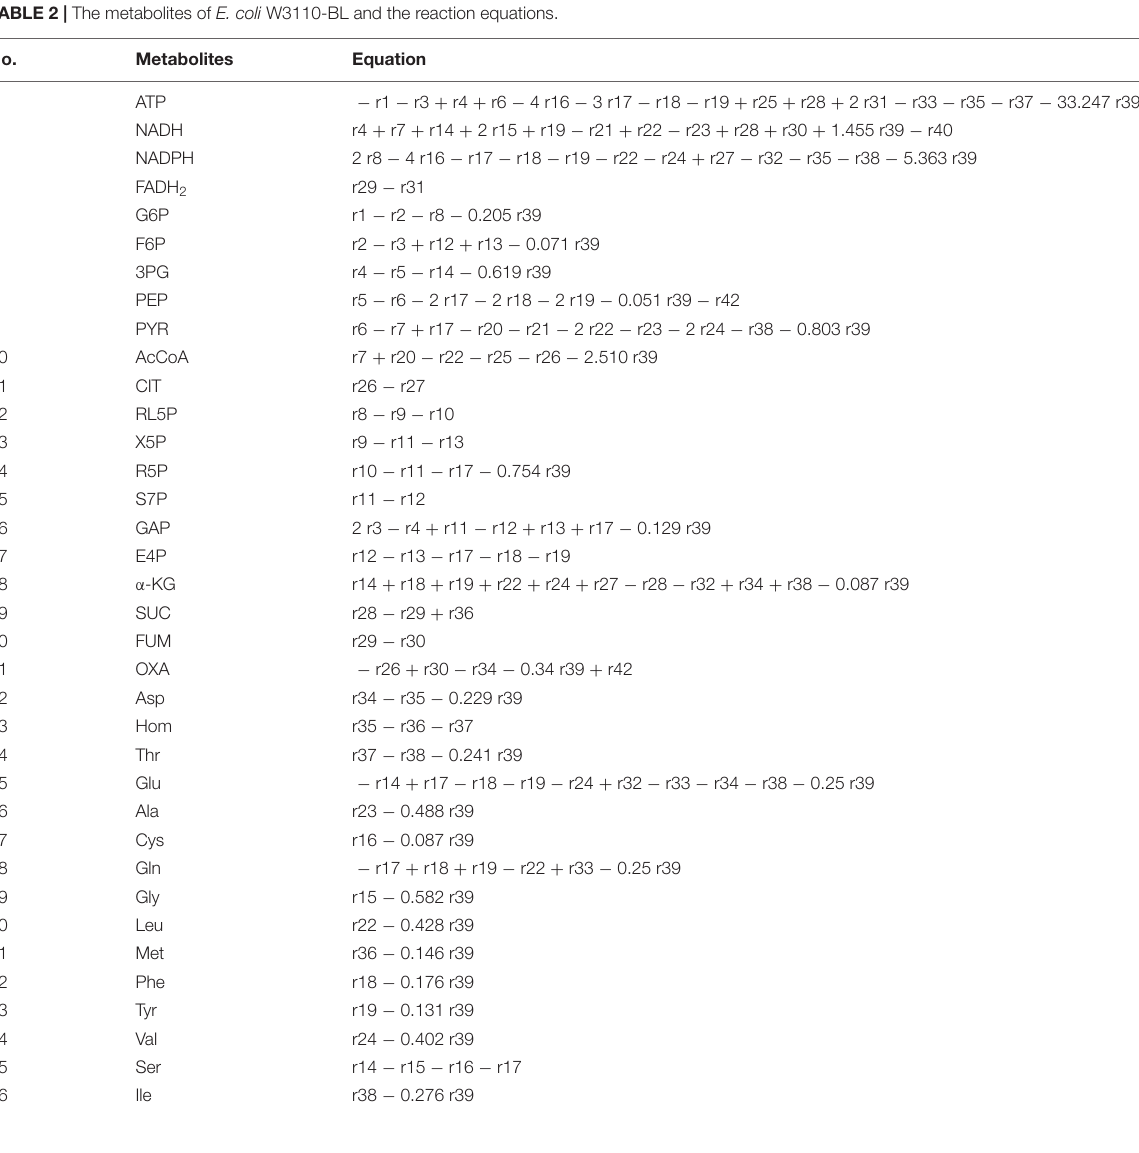
TABLE 2 | The metabolites of E. coli W3110-BL and the reaction equations.